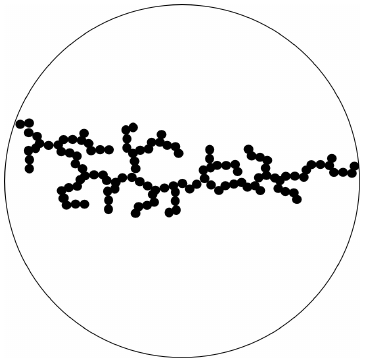
Figure 4. Gelation is assumed to occur, if a spanning cluster of particles having all the same size expands from one side of the suspended drop to the